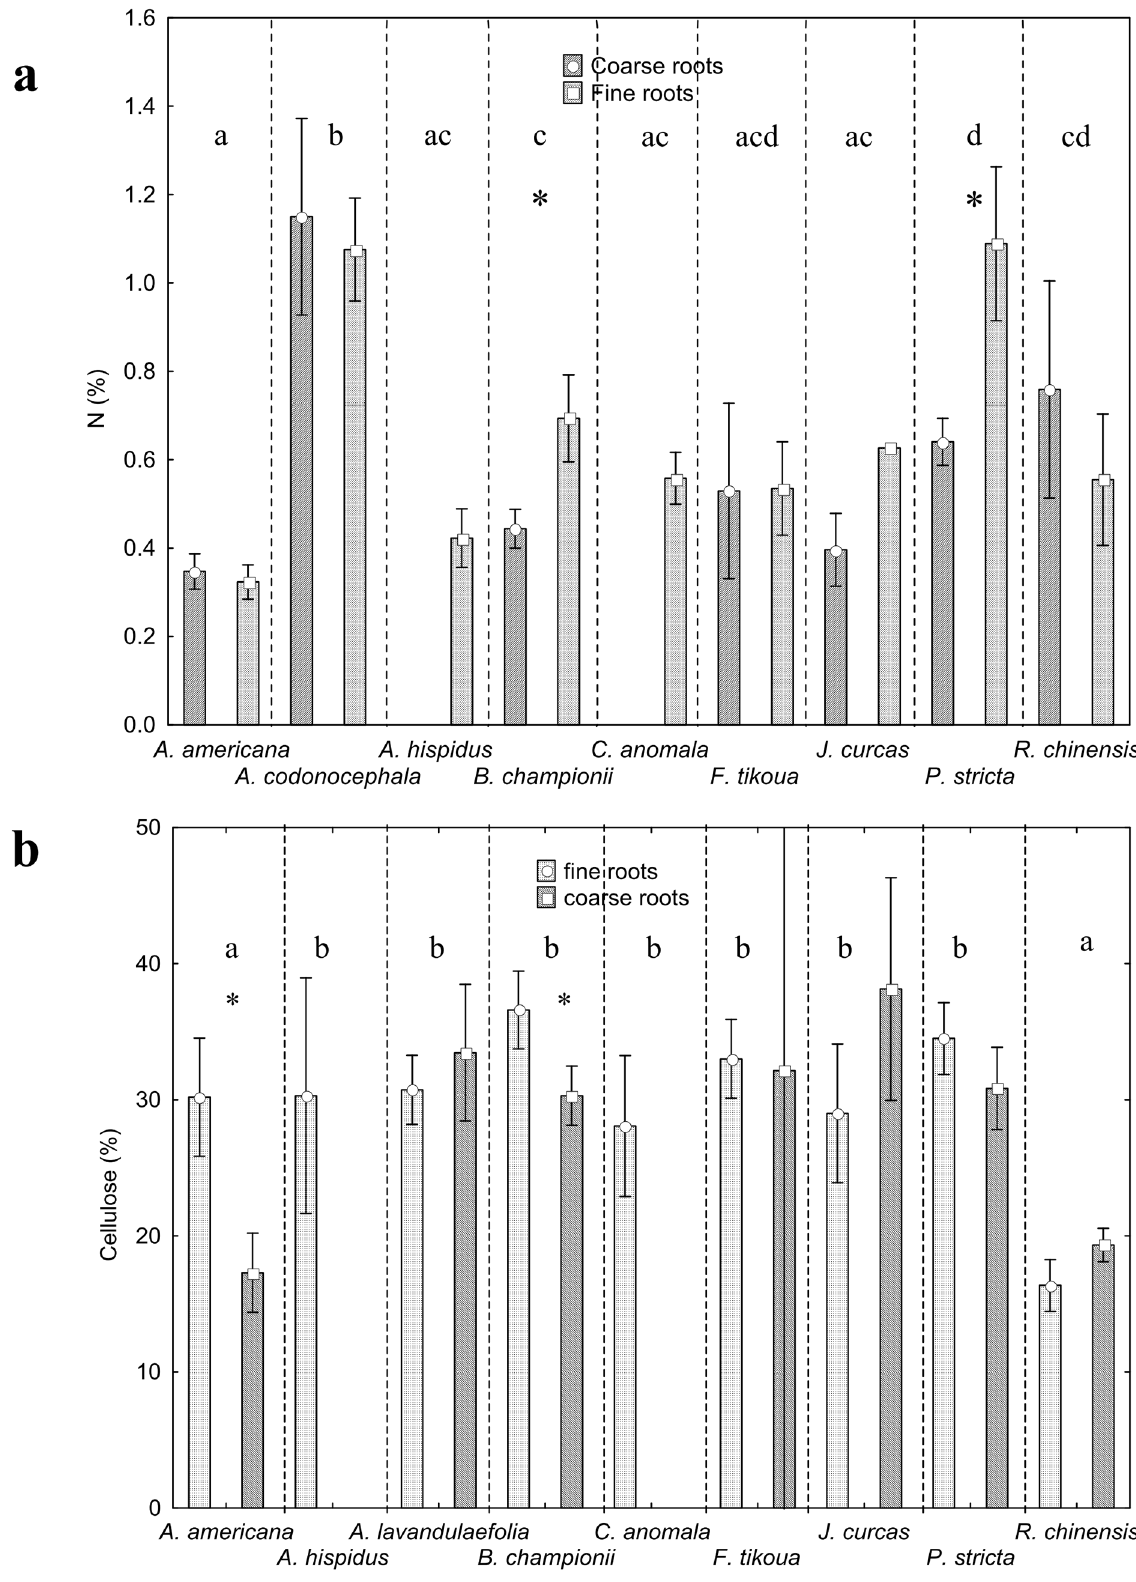
Figure 10. Nitrogen and cellulose contents. a) Nitrogen and b) cellulose concentrations in coarse and fine roots for each species. Letters indicate significant differences between species (P , 0.05) when all (coarse and fine) roots are taken into account. Asterisks denote significant differences between coarse and fine roots within a species. Vertical bars denote 0.95 confidence interval. doi:10.1371/journal.pone.0095876.g010 PLOS ONE |